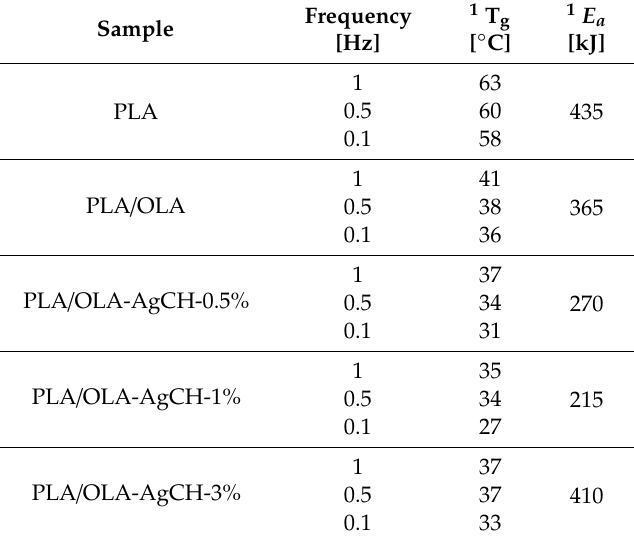
Table 1. Dynamo-mechanical thermal analyses (DMTA) results of T g .